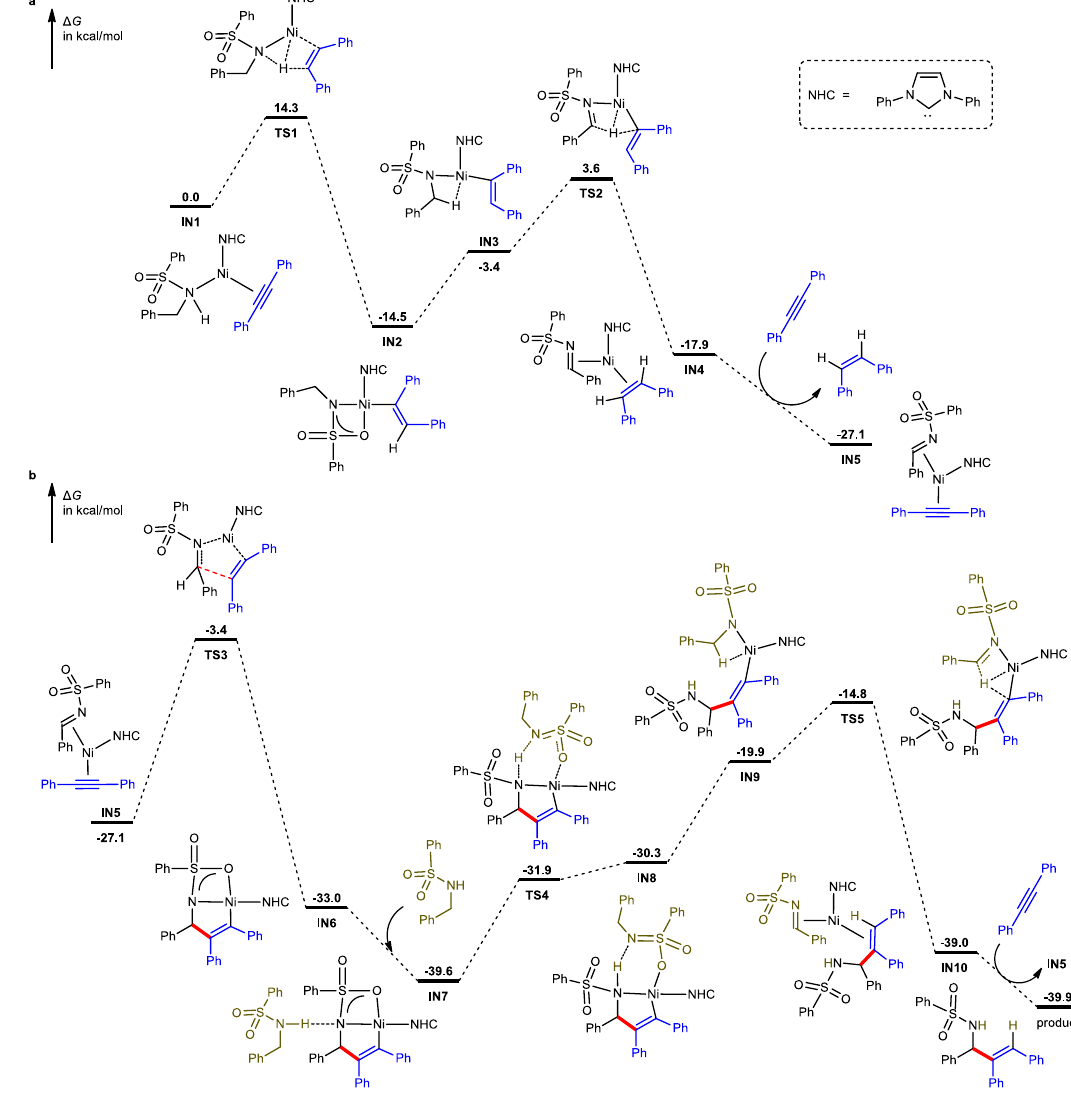
Fig. 7 DFT calculations. a Induction stage for imine formation. b Product-formation